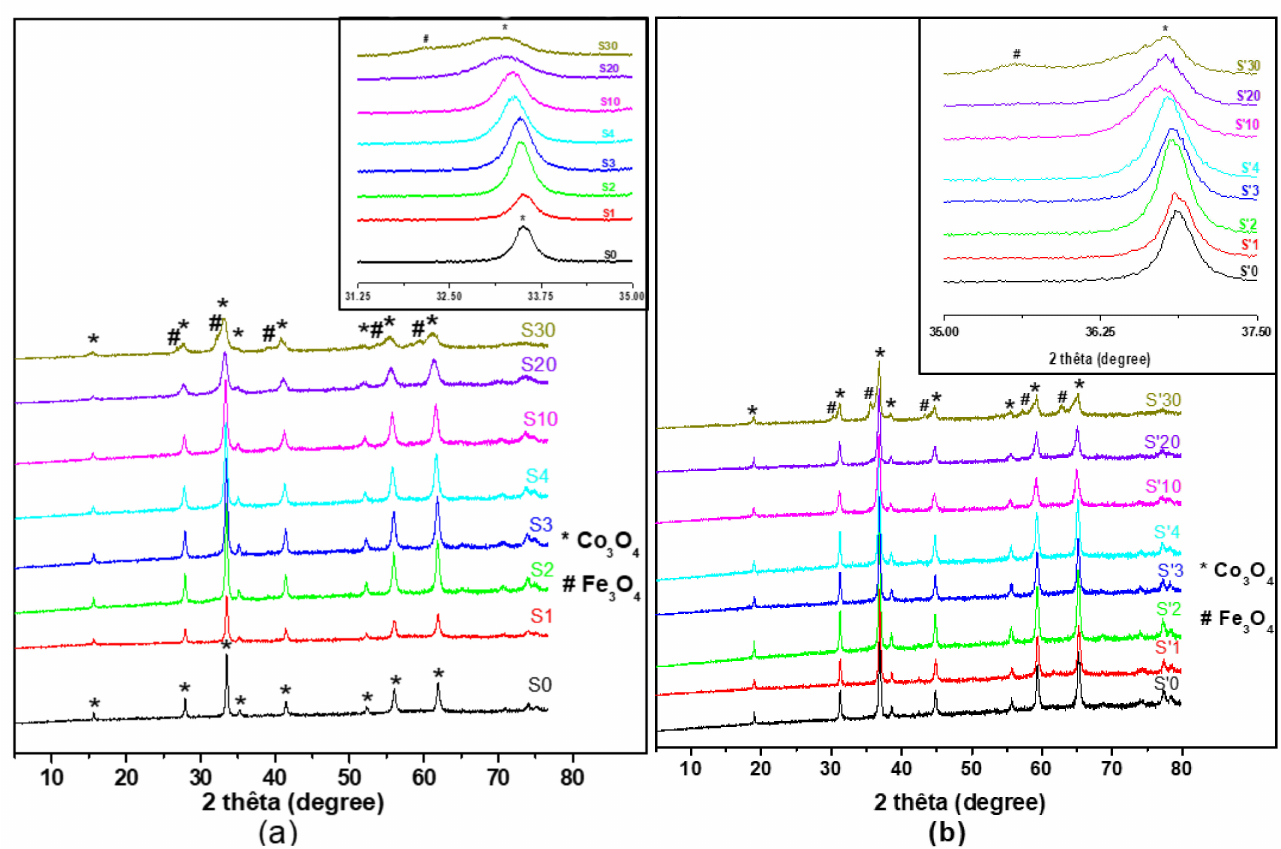
Figure 5. X-ray diffraction (XRD) of samples ( a ) S0 to S30, inset is zoom on the S samples highest peak; ( b ) S’0 to S’30 decomposition products, inset is zoom on the S’ samples highest peak. * Co 3 O 4 diffraction peaks; # Fe 3 O 4 diffraction